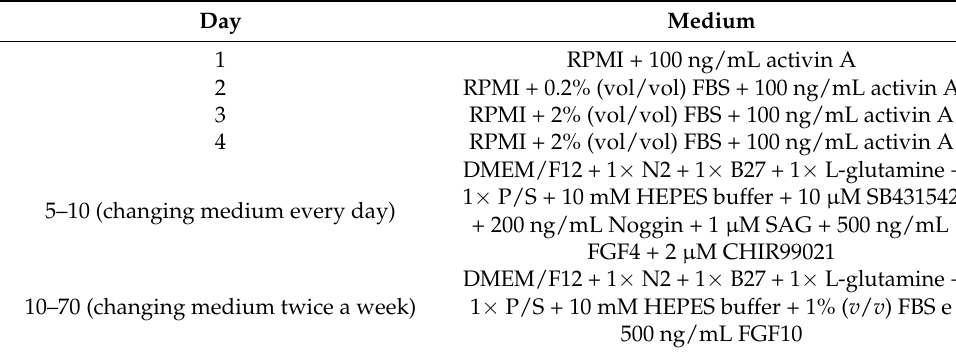
Table 2. Lung differentiation culture medium.